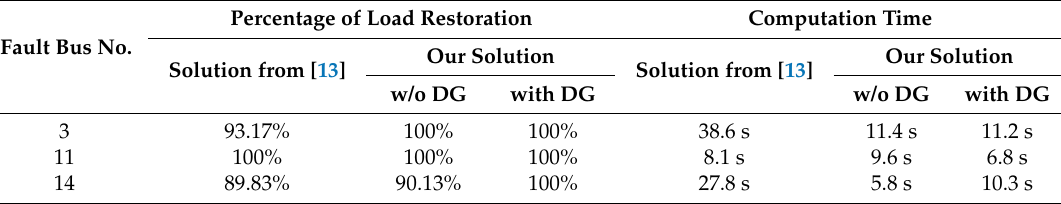
Table 2. Percentage of load restoration and computation